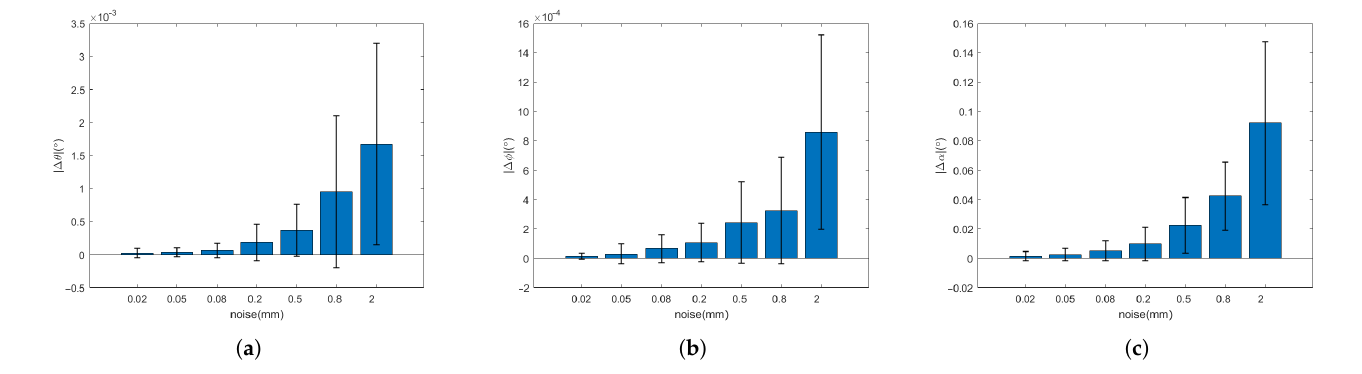
Figure 15. Standard model of circle feature.